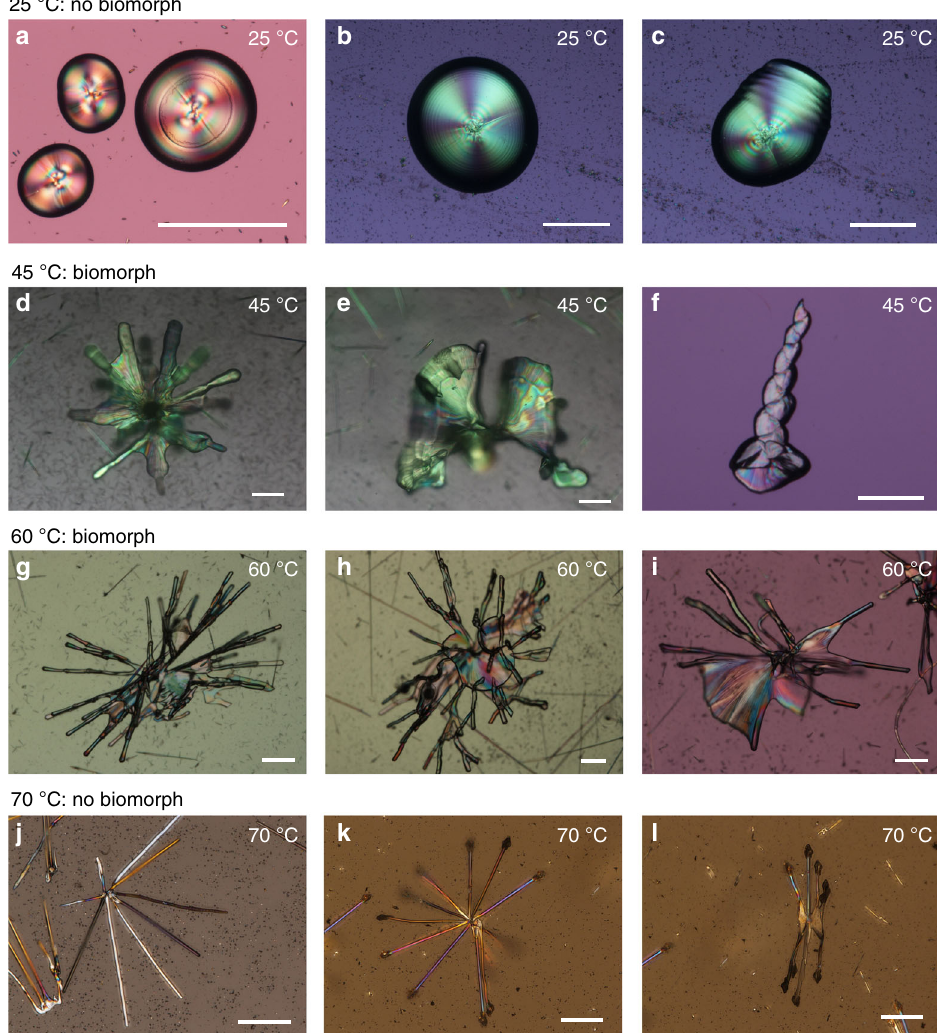
Fig. 2 MHC aggregates grown at different temperatures. Optical micrographs of hemispherical ( a , b ) and caterpillar-like ( c ) aggregates at 25 °C; fl ower-like ( d , e ) and twisted ribbon-like ( f ) aggregates at 45 °C; curvilinear sheet and fi lamentary aggregates at 60 °C ( g – i ); star-like aggregates at 70 °C ( j – l ).